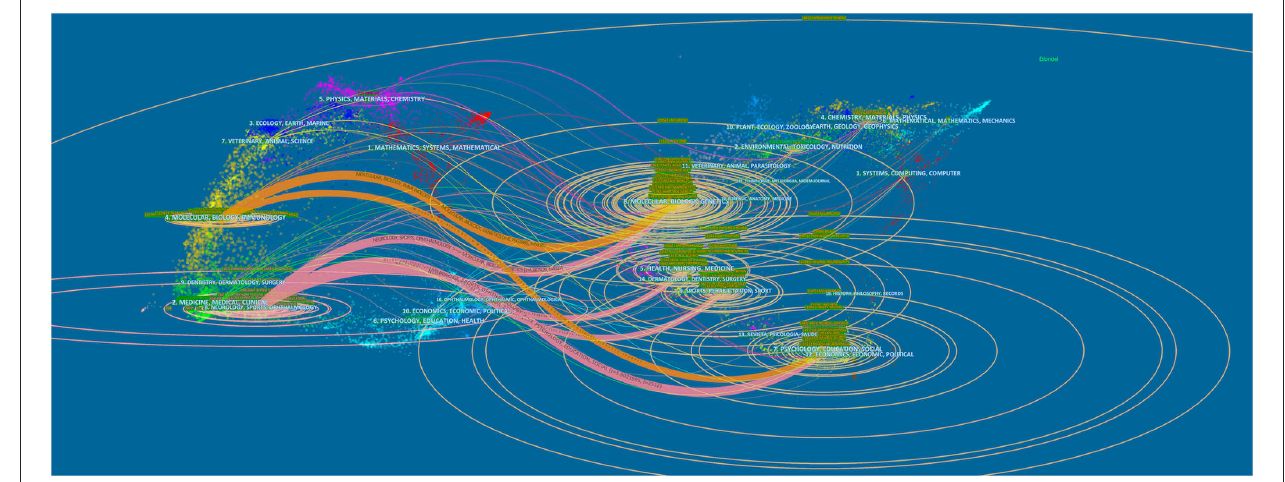
FIGURE 7 | The dual-map overlay of journals related to exercise on PD.